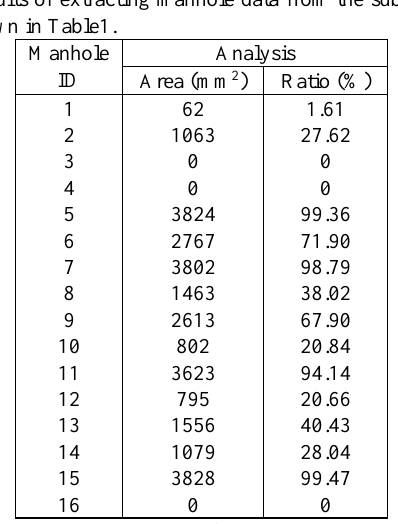
Table 1. Result of manhole